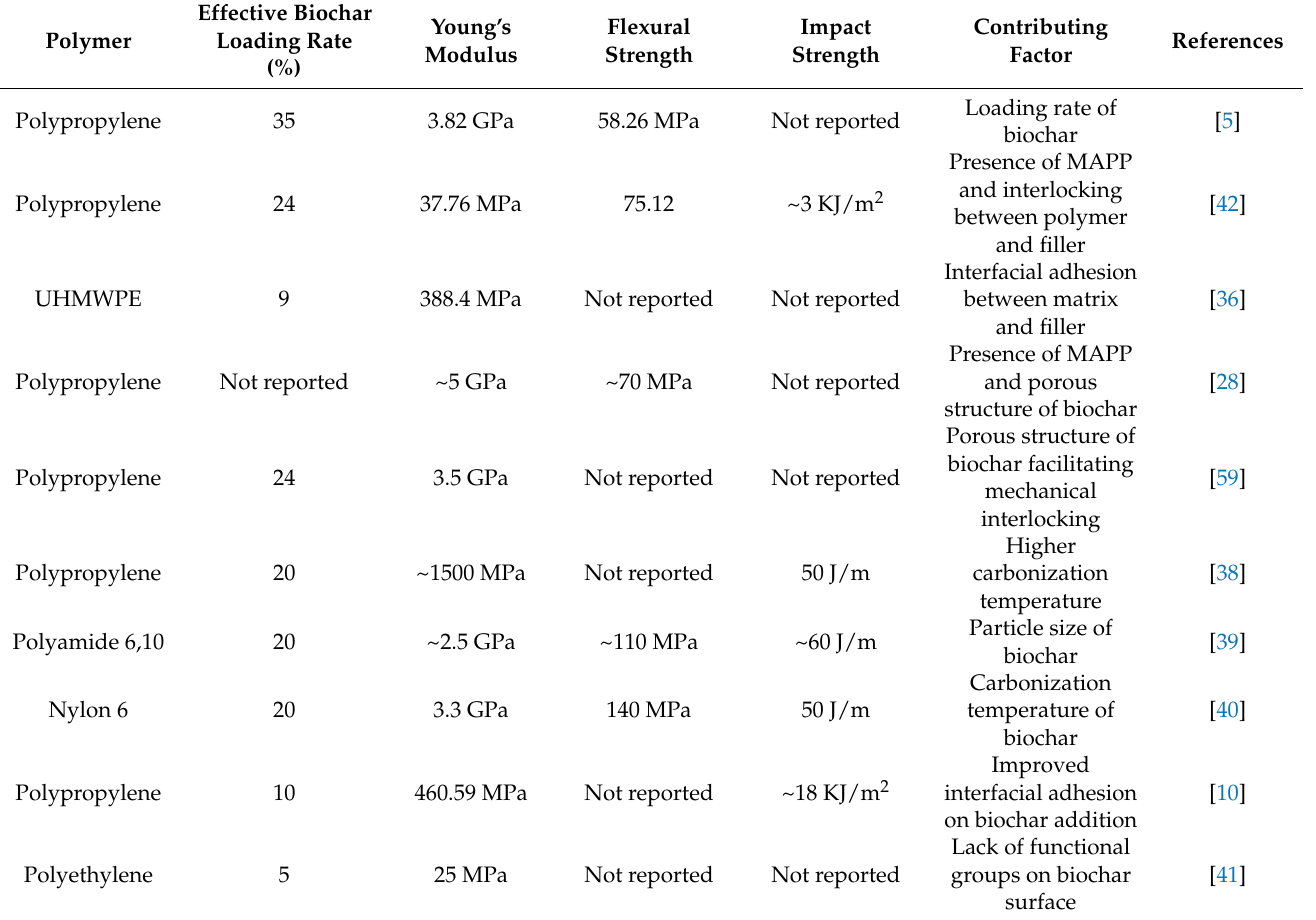
Table 2. Mechanical properties of biochar filled polymer